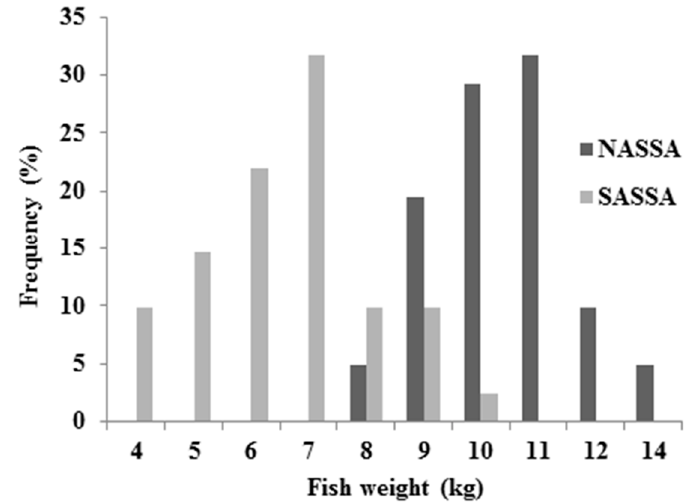
Figure 4. Weight frequency distribution for NASSA and SASSA albacore samples.